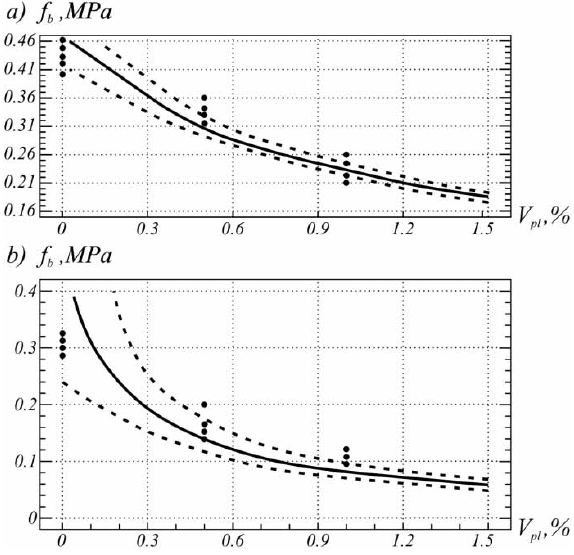
Fig. 3. Influence of plasticiser’s quantity on the strength of binder’s film during splitting, when film thickness is: (a)